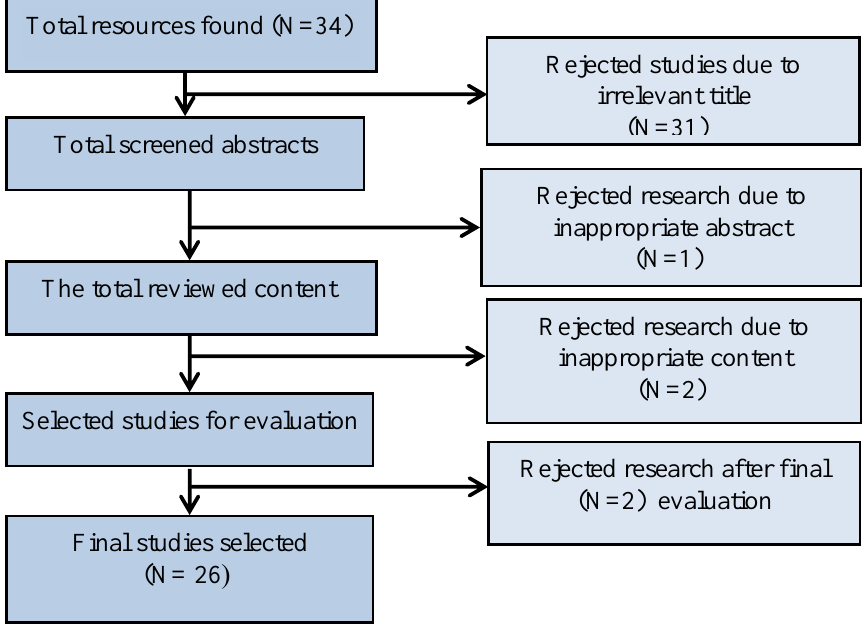
Figure 2. Review and selection process